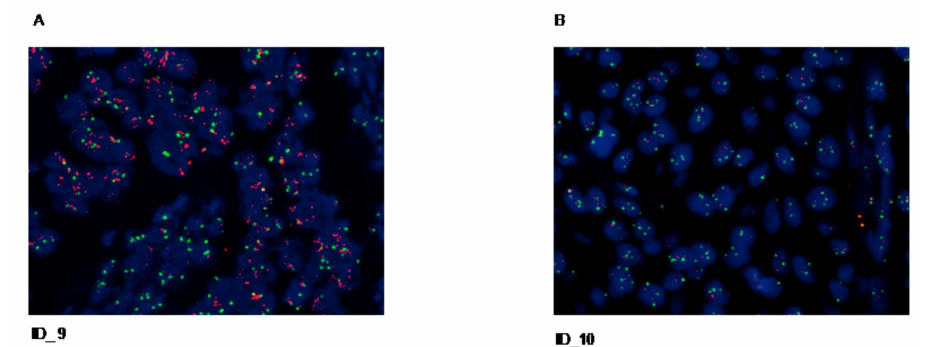
Figure 2. Representative images of fluorescence in-situ hybridization (FISH) analysis of the CDC. Red signals represent HER2 gene copies, while green signals represent chromosome enumeration probe 17 copies (oil fluorescence objective magnification ( × 60). ( A ) HER2 gene amplification; ( B ) no evidence of HER2 gene